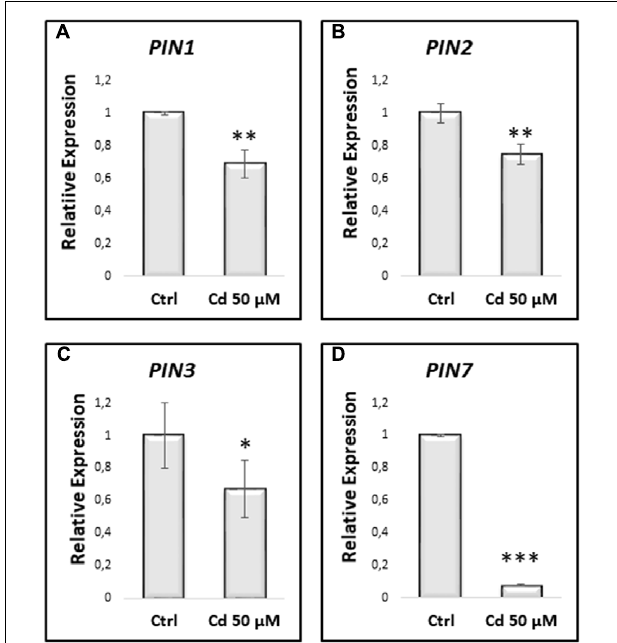
FIGURE 9 | Relative expression by qRT-PCR of PIN1 (A) , PIN2 (B) , PIN3 (C) and PIN7 (D) , in primary roots of A. thaliana seedlings germinated on growth medium as control (Ctrl); and on medium added with 50 µ M Cd for 8 DAG. Mean expression levels were calculated from three biological replicates, obtained from three independent experiments. Results were analyzed using STEP One Software 2.0 (Applied Biosystems), using the 2 - (cid:49)(cid:49) Ct method (Livak and Schmittgen, 2001). The results represent the mean value ( ± standard deviation) of three independent biological replicates. Asterisks indicate significant pairwise differences using Student’s t -test ( ∗ P < 0.05; ∗∗ P < 0.01; ∗∗∗ P < 0.001).